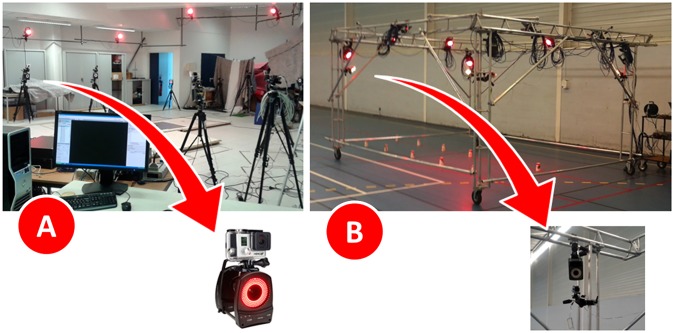
Cameras position.(A) Cameras position in the setup #1 (Reference). (B) Cameras position in the setup #2 (Steady structure) and setup #3 (Mobile structure, that involved the movement of the structure along a straight-line trajectory of 40 meters).